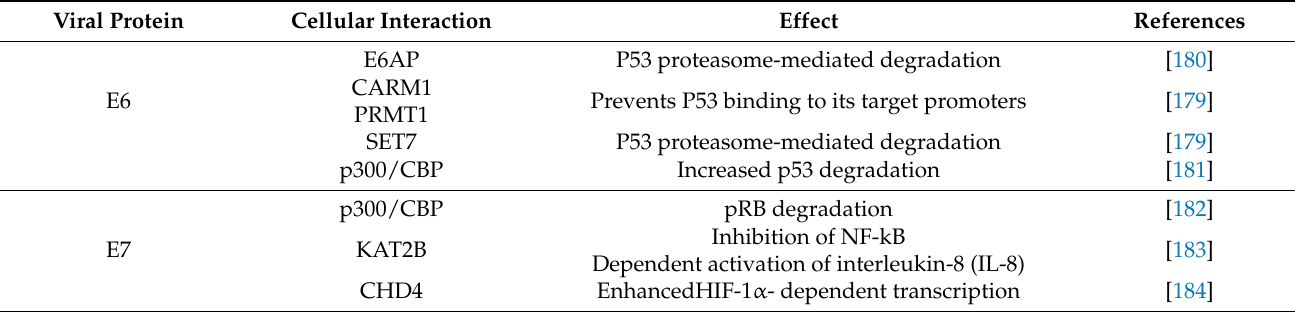
Table 1. Cellular factors that affect p53 and pRB pathways by interacting with HPV proteins E6 and E7. Viral Protein Cellular